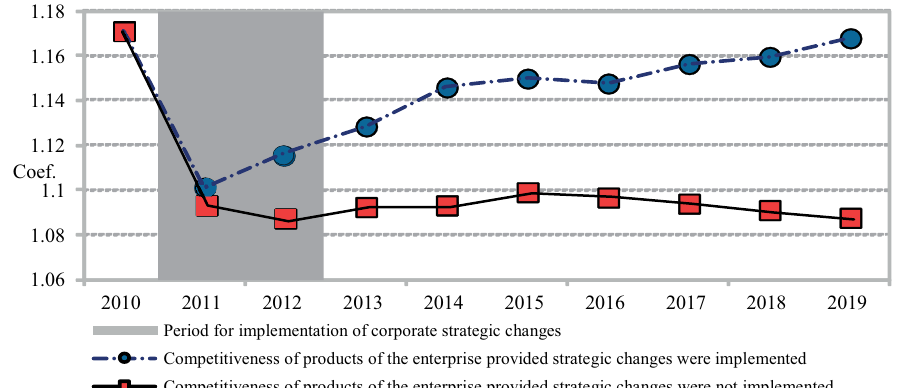
Fig. 3. Dynamics of the enterprise